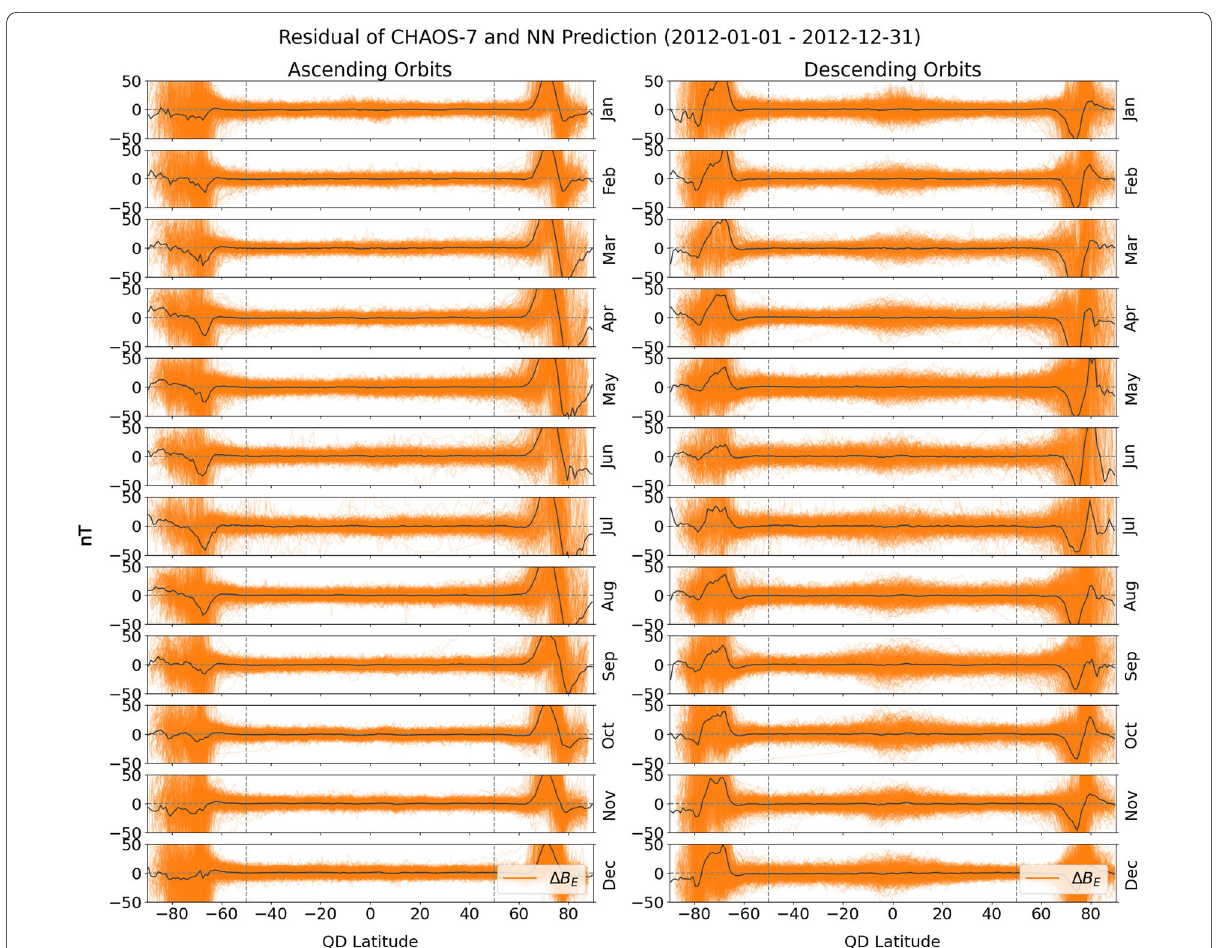
Fig. 5 Residual between the calibrated platform magnetometers and the CHAOS‑7 reference model as a function of the quasi‑dipole latitude (QDLAT) for every month of the year 2012 of the East component of the calibrated measurement in nT. The orbits are split into the ascending dusk‑orbits on the left, and the descending dawn‑orbits on the right, with the mean residual depicted in